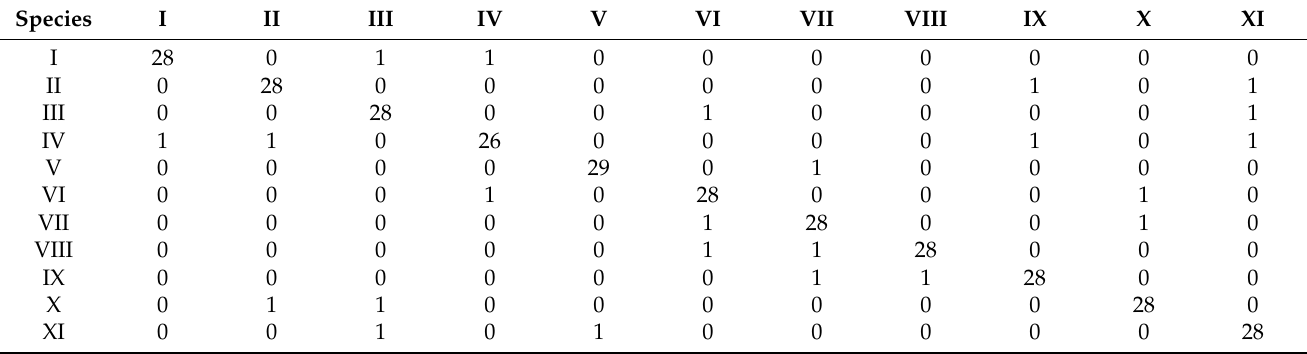
Figure 5. Visualization of average features of {MF- h (0), IMF- Si/I 1, TRIP- D rmin } of 11 rapeseed varieties in three-dimensional space. Table 3. The identification result of 11 rapeseeds species by SVMKM with K = 10.